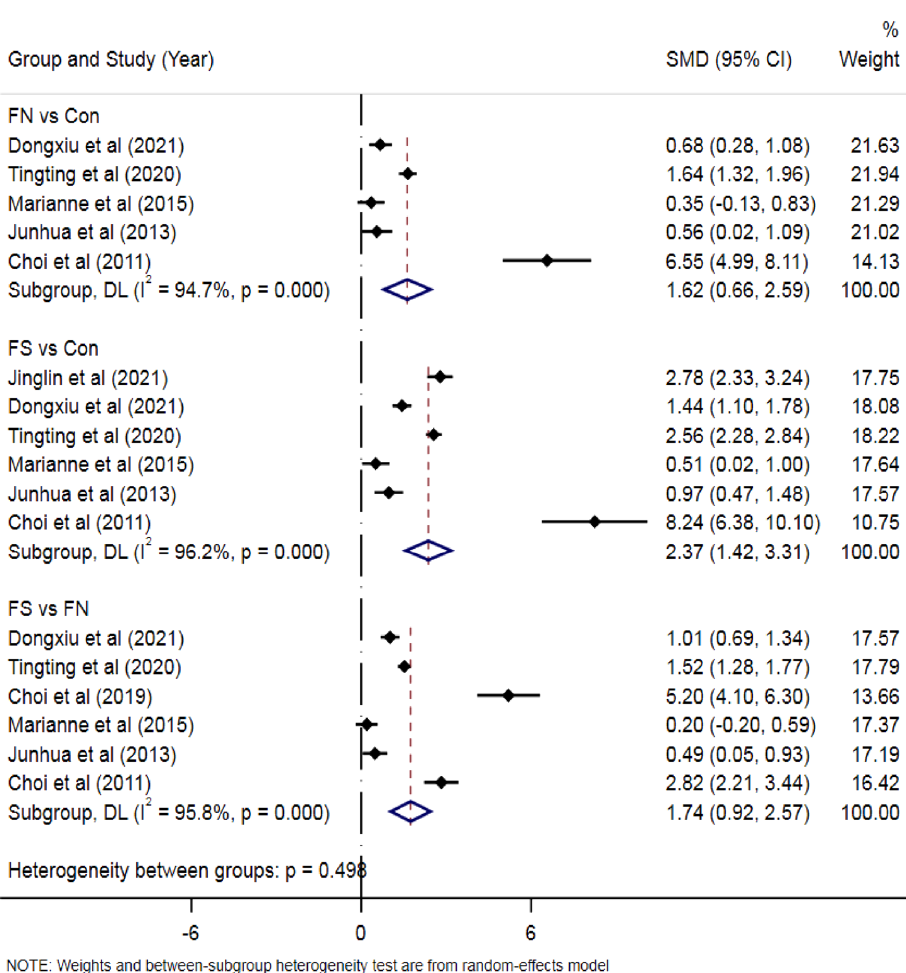
Figure 2. Forest plots of serum HMGB1 levels in FS group, FN group and healthy